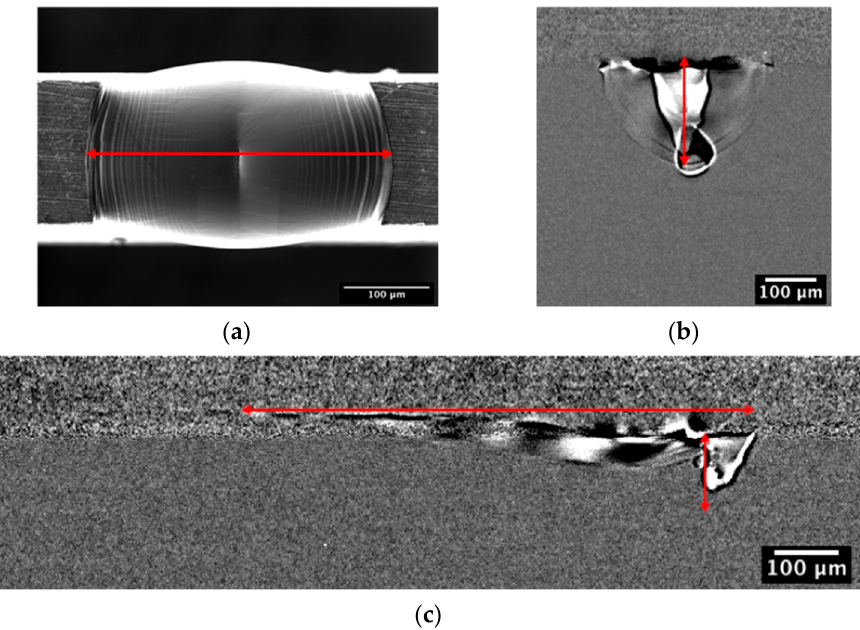
Figure 6. Methods of obtaining melt pool dimensions for calibration of model for ( a ) maximum width of a spot-melt using top-down, postmortem secondary electron imaging (SEI), ( b ) maximum depth of a spot-melt using in situ imaging, and ( c ) width and depth of a raster using in situ imaging.